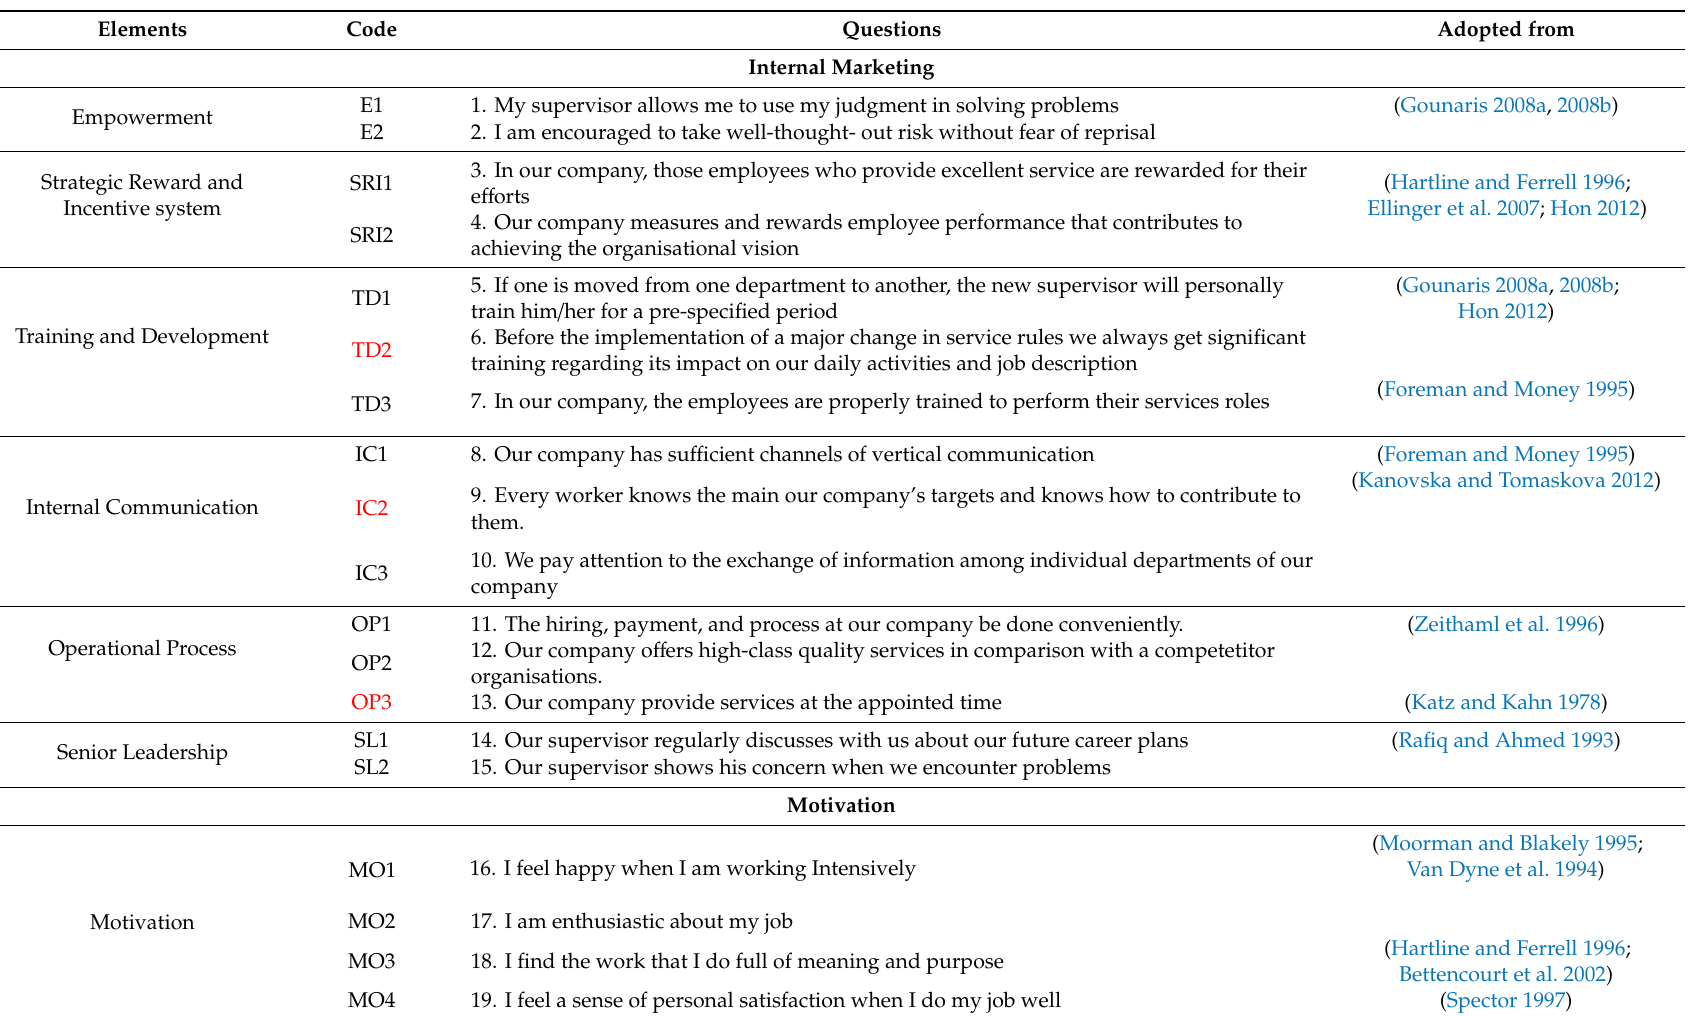
Table 1. Construct measurement